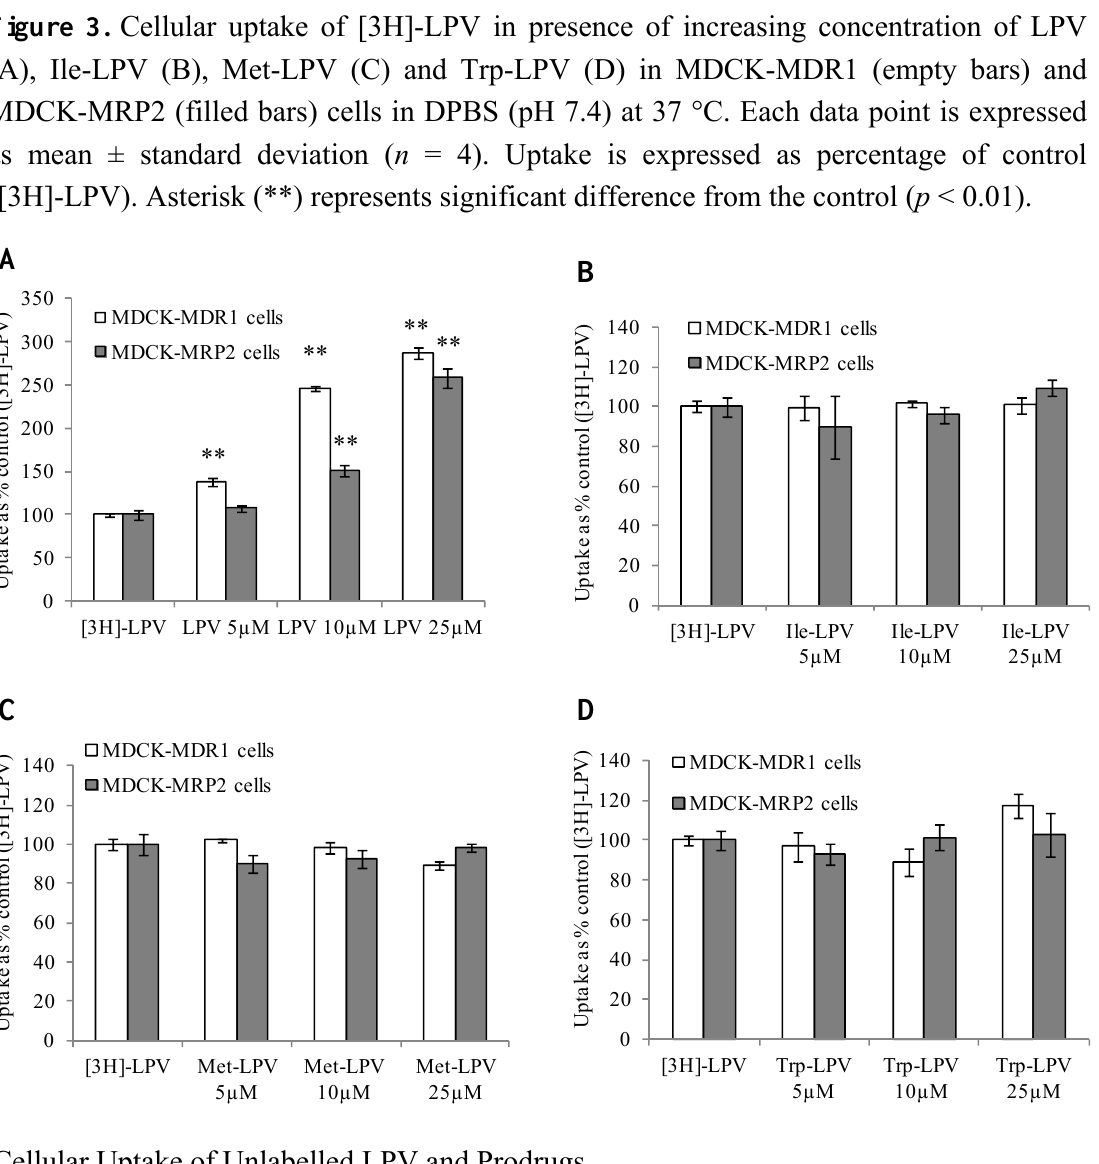
Figure 3. Cellular uptake of [3H]-LPV in presence of increasing concentration of LPV (A), Ile-LPV (B), Met-LPV (C) and Trp-LPV (D) in MDCK-MDR1 (empty bars) and MDCK-MRP2 (filled bars) cells in DPBS (pH 7.4) at 37 °C. Each data point is